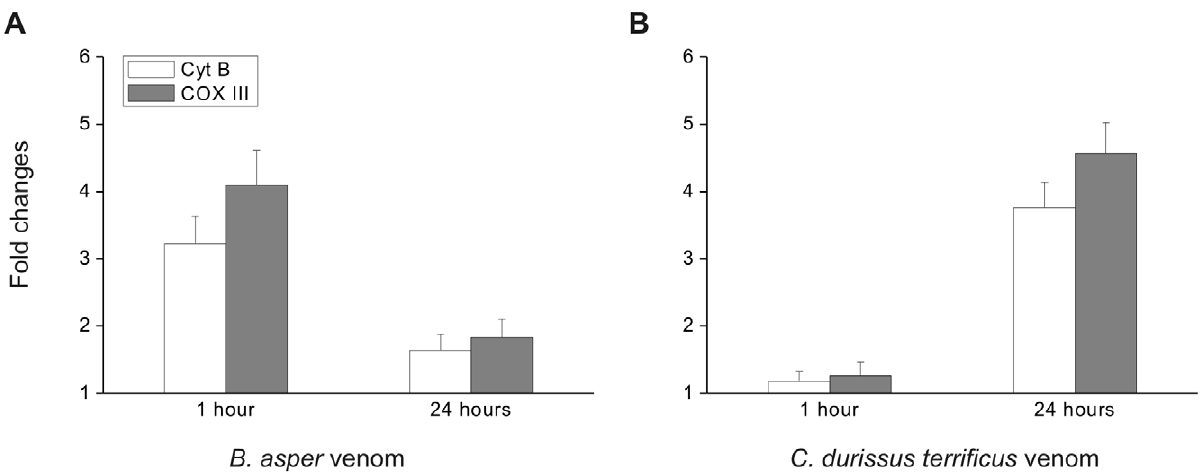
Figure 3. Envenomations by BaV and CdV result in blood circulation of mtDNA with different kinetics. Data obtained with qPCR show that mtDNA is released by intramuscular injection of the venoms. Each bar represents the fold changes of Cyt B and COX III mitochondrial genes in the plasma of mice treated (A) with BaV (5 mg/kg) or (B) with CdV (0.15 mg/kg). mtDNA was sampled from mice plasma 1 h and 24 h post-injection as indicated. Data represent the means of 3 independent experiments.